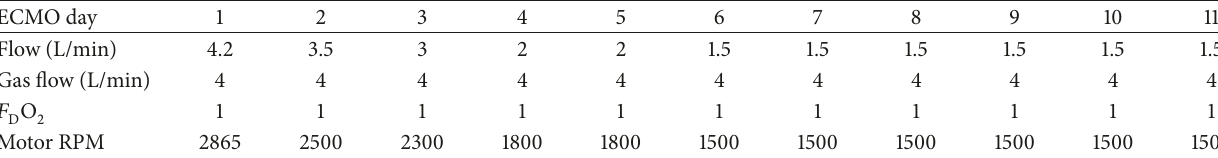
Table 1: Extracorporeal membrane oxygenation